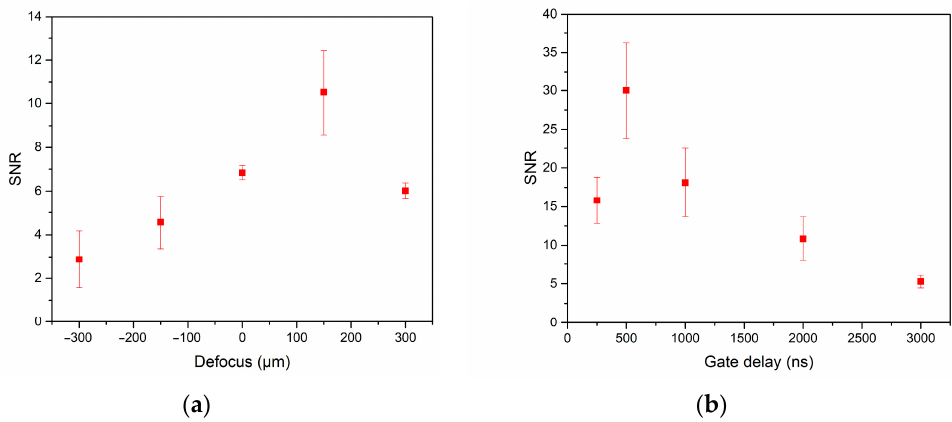
Figure 3. ( a ) The SNR dependence on defocus for zinc spectral line 334.50 nm. Negative defocus means focusing the collection optics above the sample surface, positive defocus means focusing the collection optics under the sample surface, zero stands for the sample surface. ( b ) The SNR dependence on gate delay.